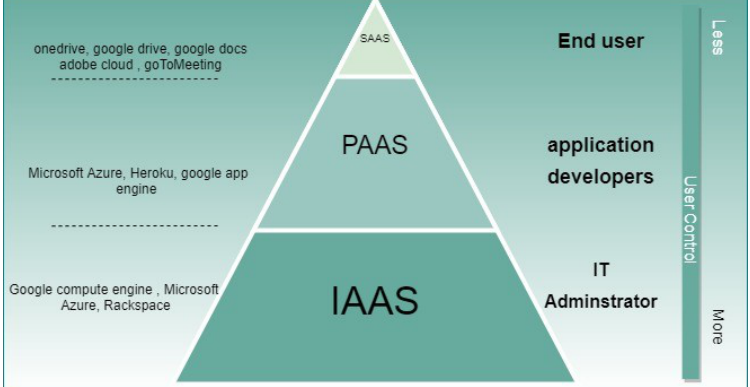
Figure 1. Cloud services level